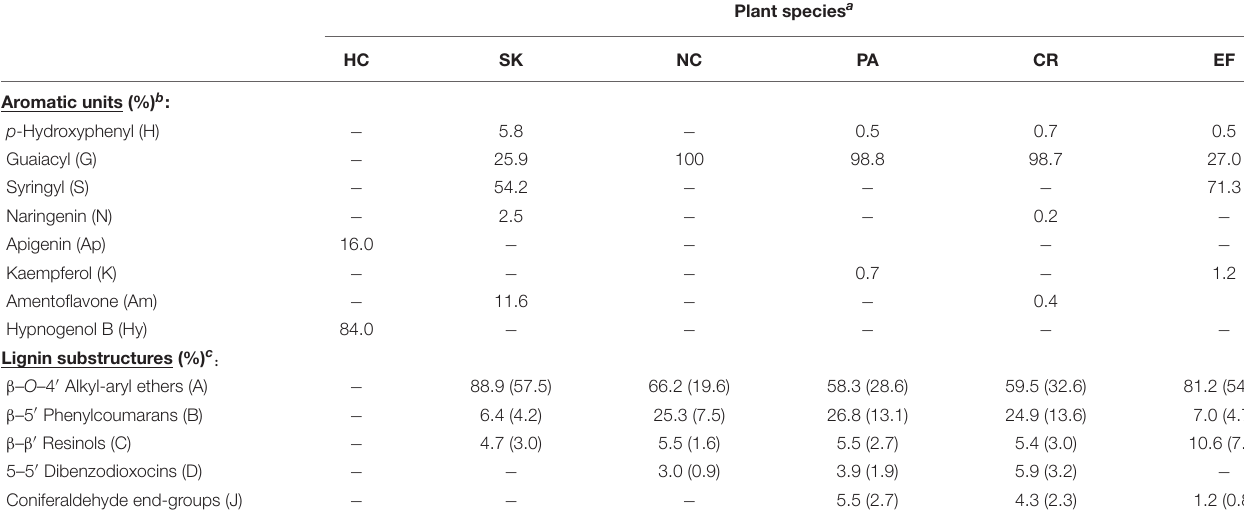
TABLE 3 | Semiquantitative analysis of lignin aromatic units (flavonoid units included) and different substructures, from integration of HSQC spectra (see Figures 3–6 also showing structural formulae) of the lignin-like fractions from ancestral